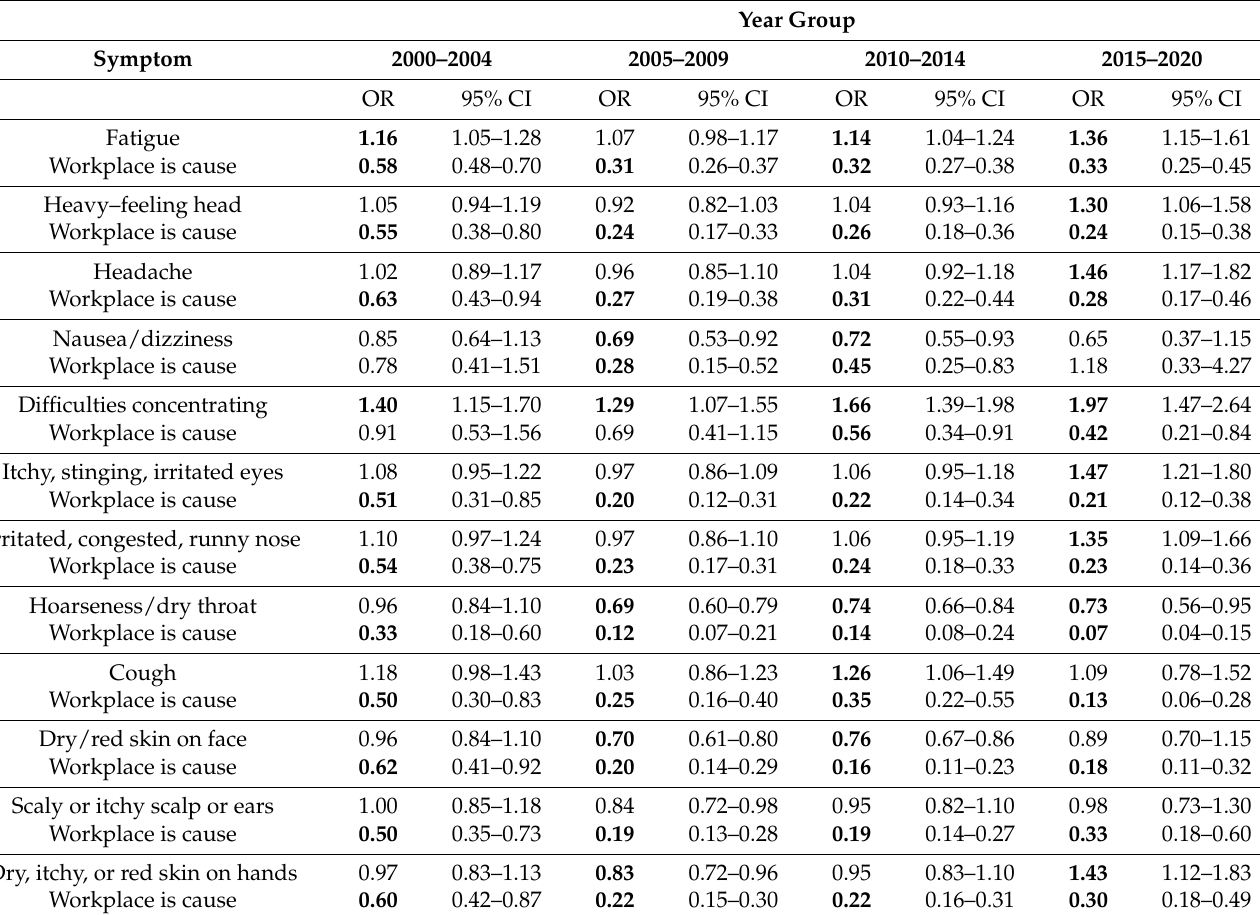
Table 4. Logistic regression analyses of questionnaire answers regarding symptoms and perceived causality to the office environment, compared to the first-year group (1995–1999, OR 1), and adjusted for sex and atopy. Questionnaires were divided into five 5-year groups based on year of filling in. OR = odds ratio, CI = confidence interval. Bold = significant at p <